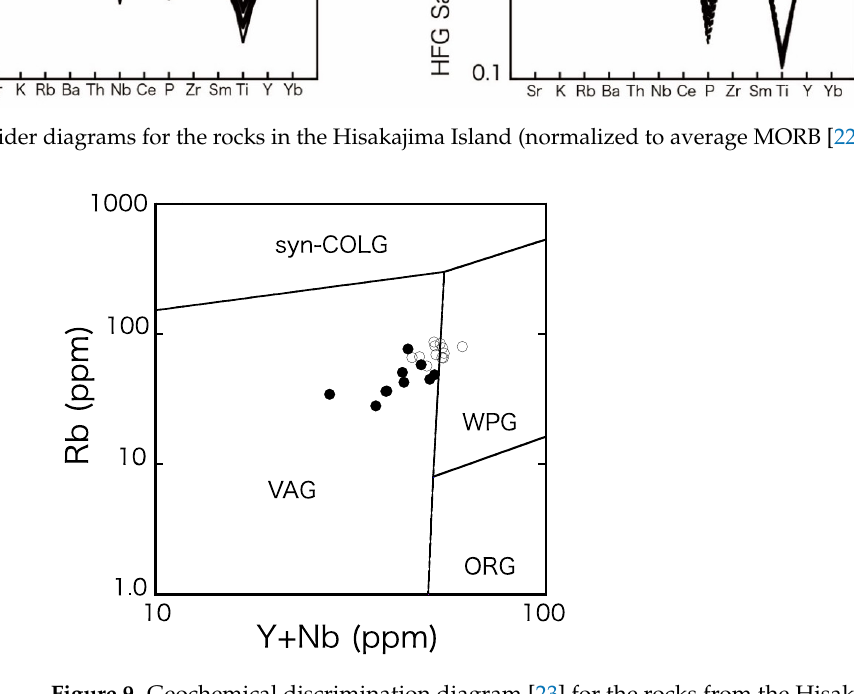
Figure 9. Geochemical discrimination diagram [23] for the rocks from the Hisakajima Island. syn- COLG — collisional granites. VAG — volcanic-arc granites. WPG — within-plate granites. ORG — ocean-ridge granites. Solid circles — GD group samples. Open circles — HFG group samples.